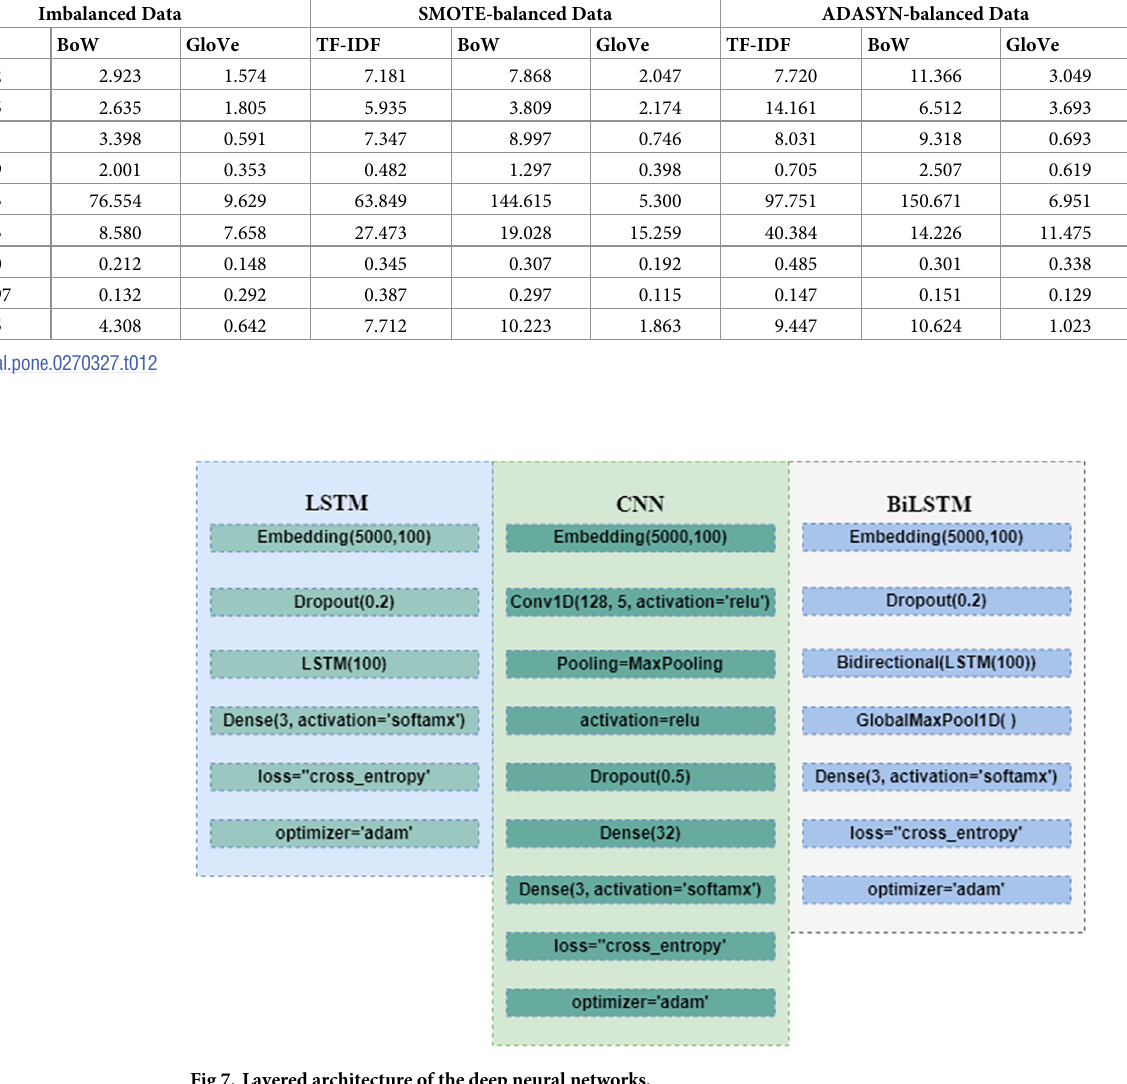
Fig 7. Layered architecture of the deep neural networks.